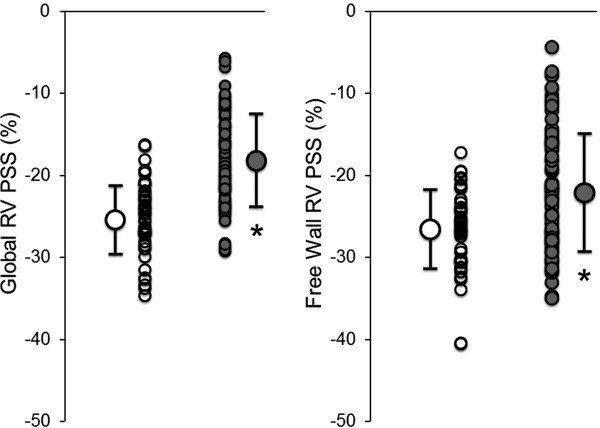
Plots shows comparisons of global (left) and free wall (right) RV peak systolic strain (PSS) between the Control (open circle, n = 45) and OMI groups (gray circle, n = 71). *p <0.05 vs. the Control group.